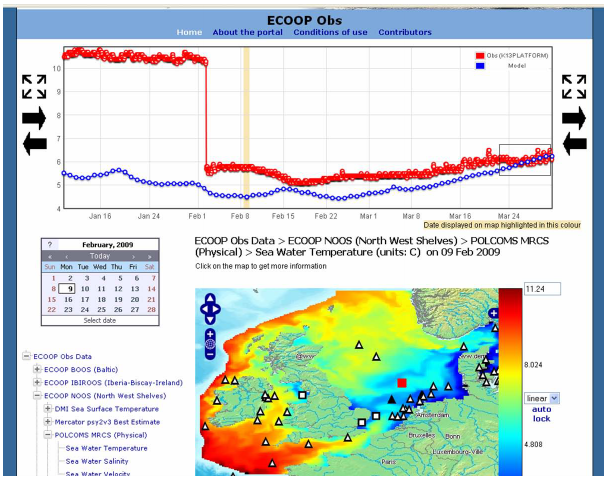
Fig. 5. Portal screenshot showing an extended timeseries of sea water temperature (red line, two-hourly data feed) from the K13 Platform in the North Sea (solid black triangle) and from the POL- COMS MRCS model (blue line, daily average). The elevated tem- peratures present in the observed data for the first third of the time- series are erroneous, and the correction of this problem is clearly seen as later temperatures are in much closer agreement with the model data. The black rectangle on the right of the timeseries plot denotes the area of the zoomed-in timeseries in Fig. 7, which also contains a timeseries from the OysterGround SmartBuoy to the North East of the K13 platform (red square).